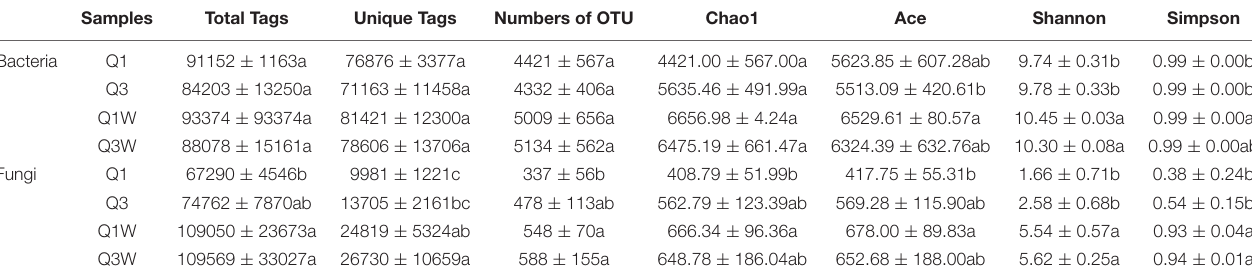
TABLE 3 | The statistics analyze of sequences information and alpha diversity index of bacteria and fungi from ON and OUT zone of Leucocalocybe mongolica fairy rings. Samples